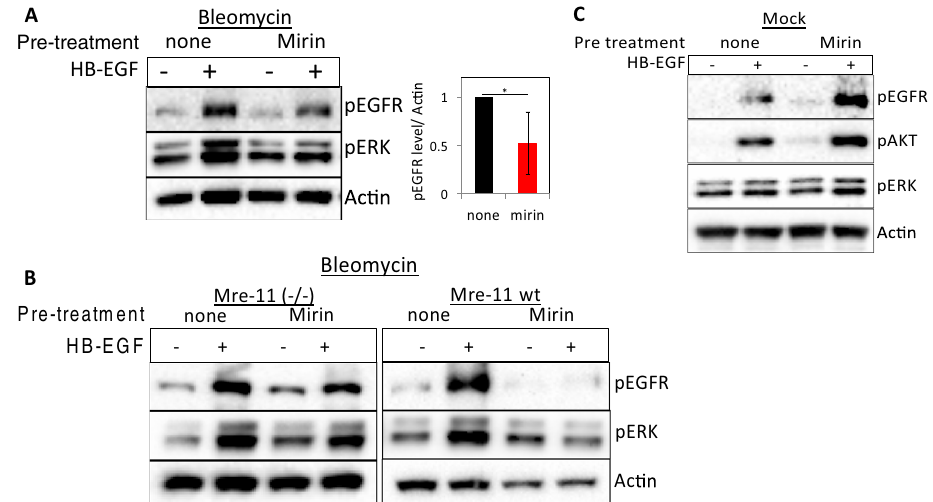
Figure 2. Pharmacological inhibition of Mre-11 interferes with ligand-dependent EGFR signaling in cells suffering from DNA damage. ( A ) HF were either left untreated or treated with mirin (100 µM) for one hour and then were treated with bleomycin for an additional 30 min followed by HB-EGF (10 ng/ml) treatment for 10 min. ( B ) ATLD2 cells (Mre-11 −/− ) or ATLD2 cells reconstituted with wild type Mre-11 (Mre-11 wt) were treated as in ( A ). ( C ) HF were either left untreated or treated with mirin for one hour and then left untreated (mock) and HB-EGF was added for 5 min. Cells were lysed and subjected to Western blot analyses using the indicated antibodies as above. pEGFR signal intensities were quantified and normalized as in Fig. 1 (n = 5). Representative results of at least three independent experiments are